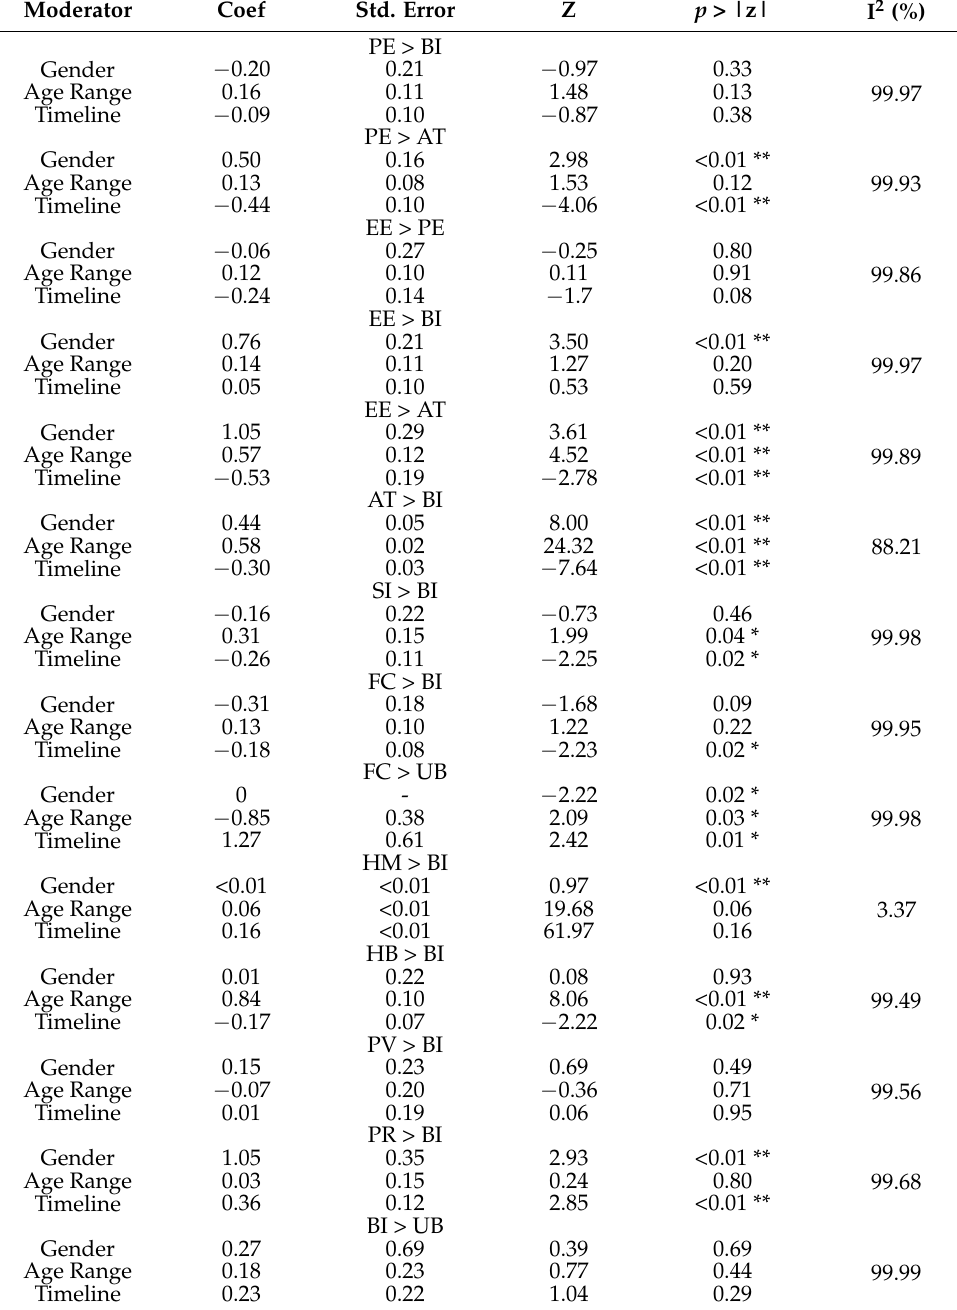
Table 4. Meta-regression of the moderating